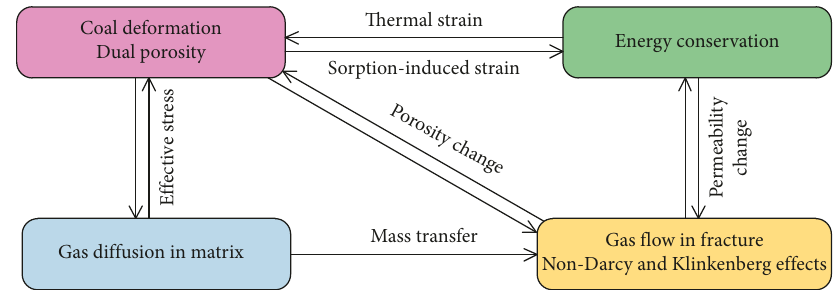
Figure 2: Couplings in the gas migration process.